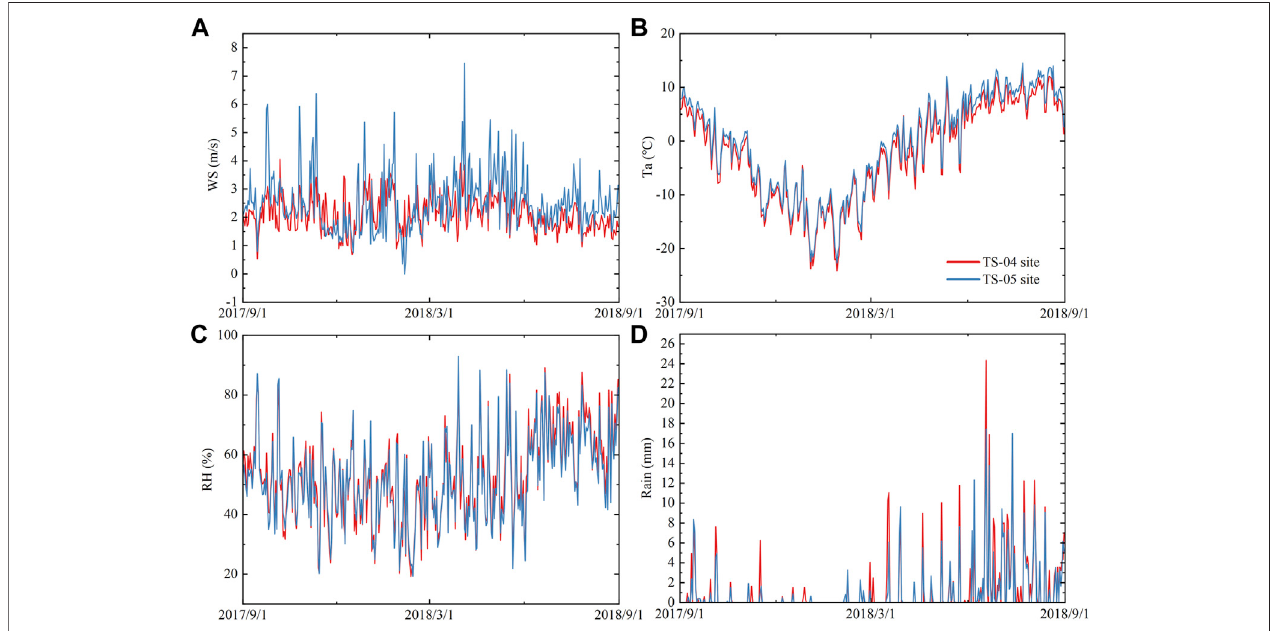
FIGURE 2 | Comparison of meteorological data between TS-04 and TS-05 stations. (WS, Wind Speed; Ta, Air temperature; RH, Relative humidity).